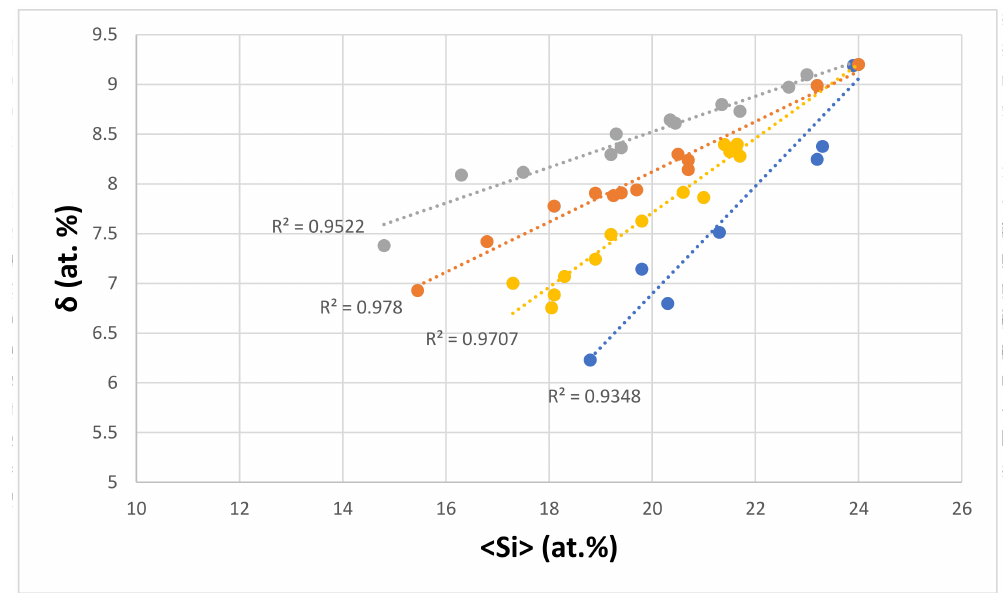
Figure 8. δ versus <Si> of eutectics with Nb ss and Nb 5 Si 3 in Nb-silicide based alloys. Series a (R 2 = 0.9707) with alloying element additions of Al, Cr, Fe, Ge, Hf, Mo, Si, Sn, Ti, V, and W; series b (R 2 = 0.9348) with alloying element additions of Al, Cr, Ge, Hf, Si, Sn, Ta, Ti, V, and W; series c (R 2 = 0.9522) with alloying element additions of Al, Cr, Fe, Ge, Hf, Mo, Si, Sn, Ta, Ti, V, W, Y, and Zr; and series d (R 2 = 0.978) with alloying element additions of Al, Cr, Ge, Hf, Mo, Si, Sn, Ta, Ti, and